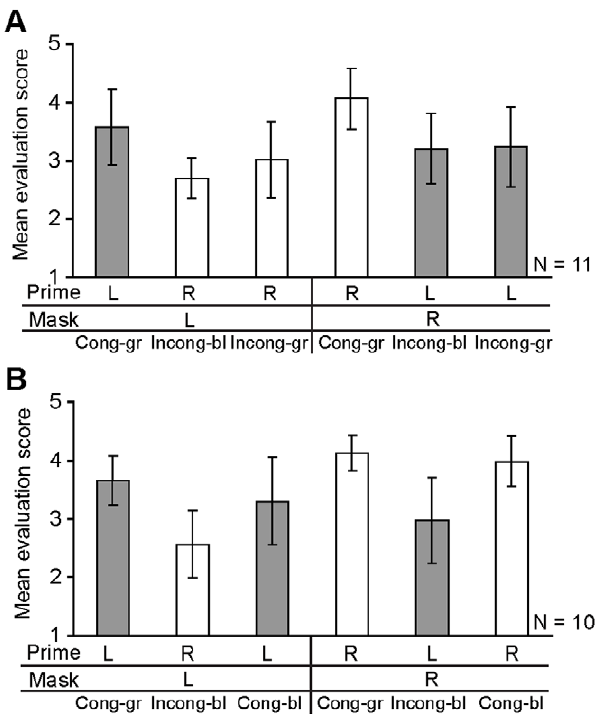
Figure 7. Mean evaluation scores in the test phase. (A) Incongruent-green group and (B) congruent-blue group. Cong-gr, Incong-bl, Cong-bl, and Incong-gr denote congruent-green, incongru- ent-blue, congruent-blue, and incongruent-green conditions, respec- tively. doi:10.1371/journal.pone.0034985.g007 the prime-mask stimulus combination was incongruent (incongru- ent-blue condition), as shown in Fig. 2A. There are two possible motor clues for action evaluation: (i) afferent information from the motor behavior modulated by the invisible prime and (ii) endpoint error. Path analyses (Fig. 6) revealed that a majority of the participants used appropriately afferent information from their own motor behavior for action evaluation, while the endpoint error also provided a moderate clue for such evaluation. An interesting result of the present study is that, although the endpoint